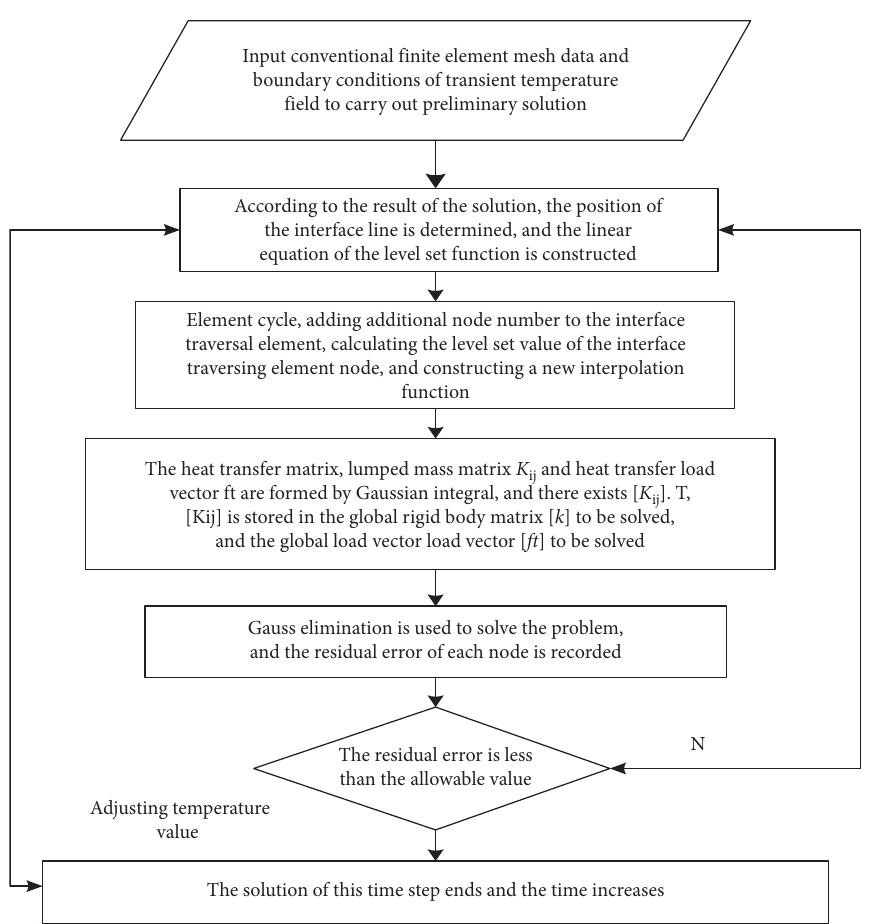
Figure 3: The flow chart for the Table 1: Basic property indexes of soils.